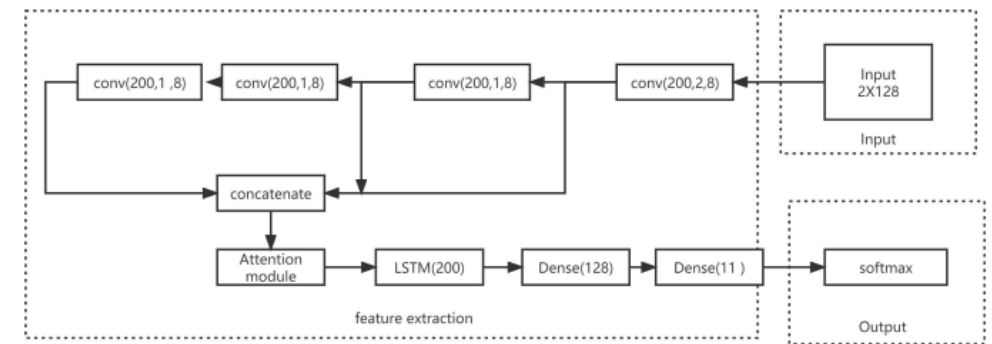
Figure 3. ASCLDNN network